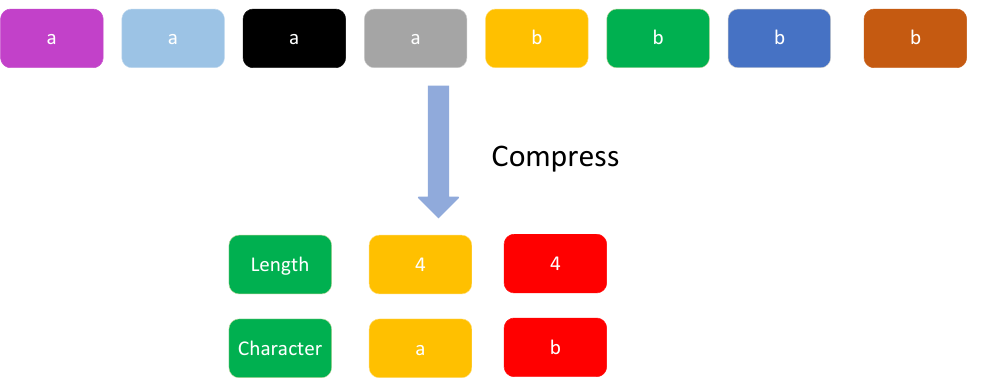
Figure 2. Pattern sequence before and after